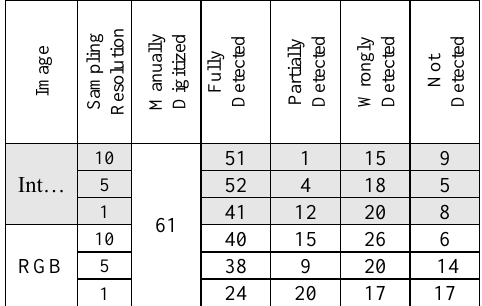
Table 2. The number of detections per classification.